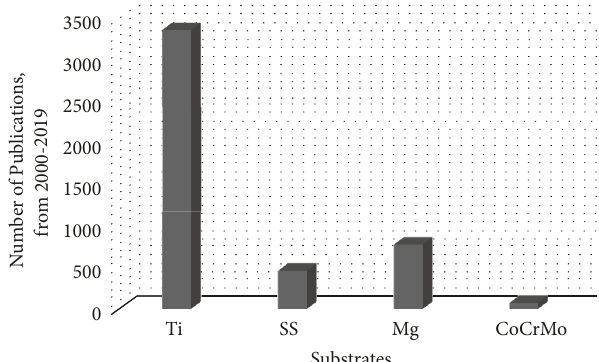
Figure 1: The approximate number of published articles of HAp deposition on different types of biomedical substrates from 2000 to 2019.